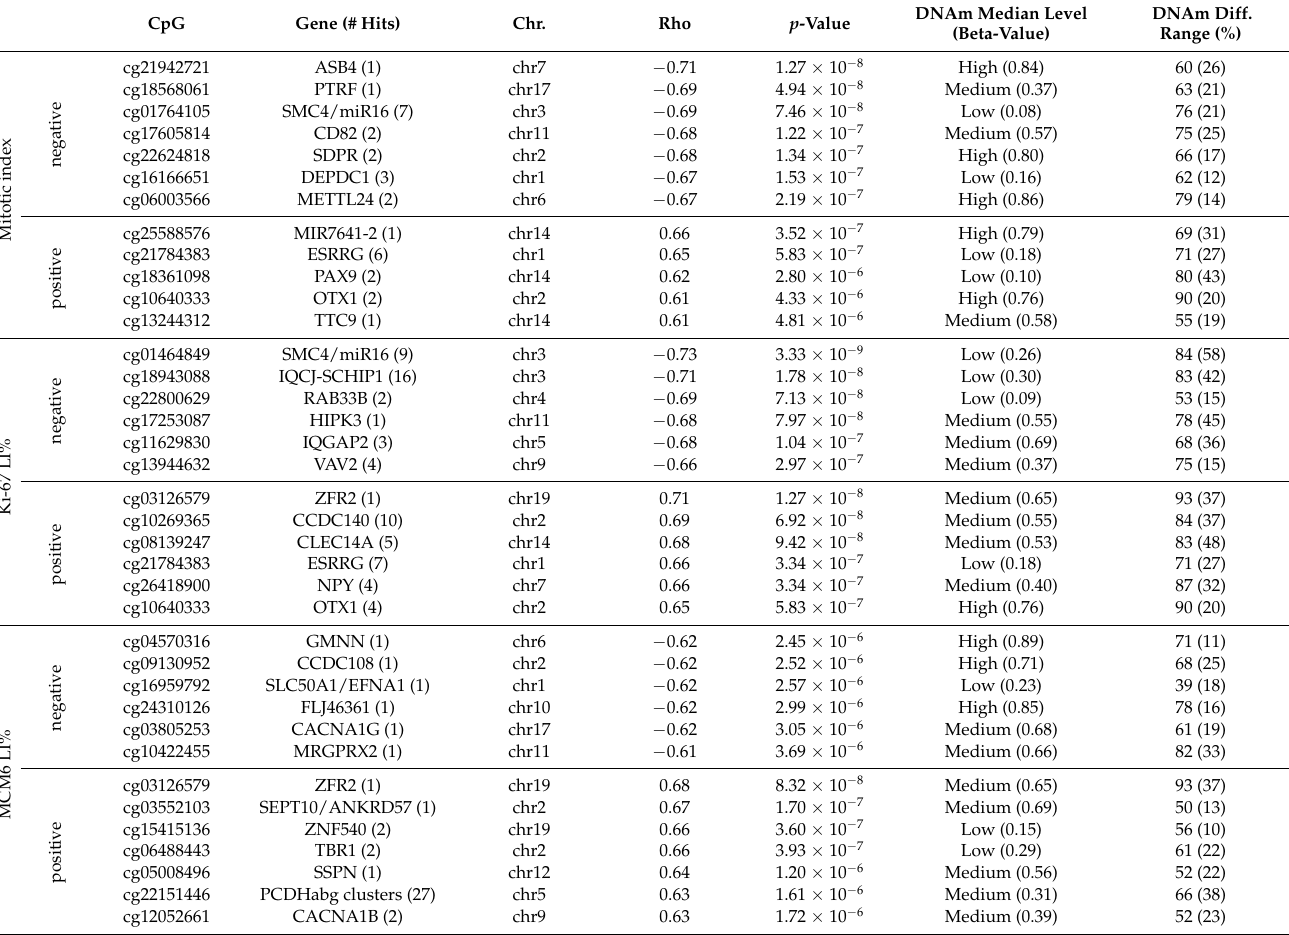
Table 5. Top correlated CpGs between DNAm levels (beta values) and mitotic indices, Ki-67 labeling indices, and MCM6 labeling indices in regulatory region contexts. Chr. Rho p -Value DNAm Median Level (Beta-Value) DNAm Diff. Range